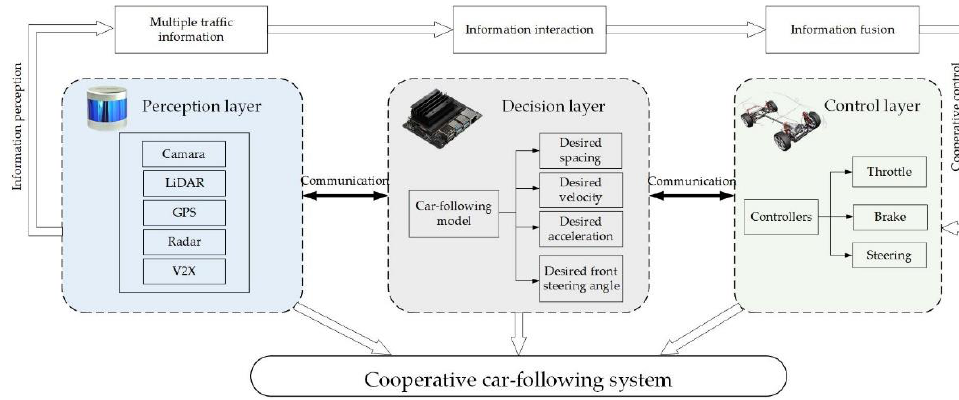
Figure 1. The framework of the cooperative car-following system based on eco-driving.